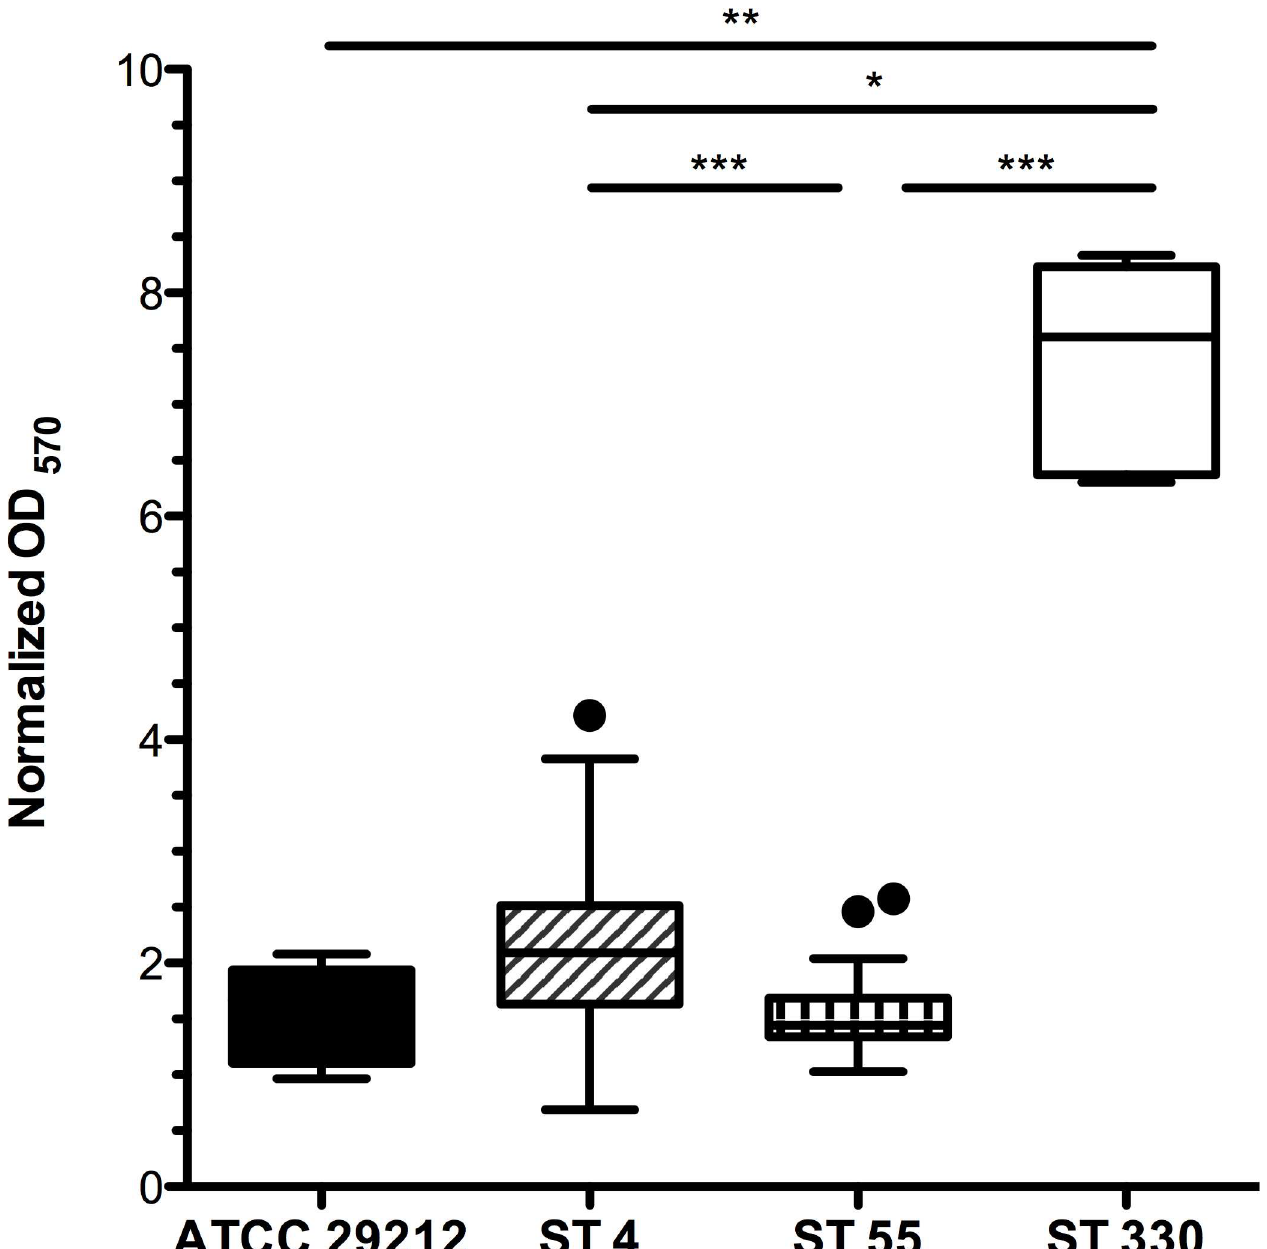
Fig 3. 24 hour Biofilm Production for 15 E . faecalis Isolates Assessedby Crystal Violet Staining. ST 4 and ST 330 isolates produce significantly more biofilm than ST 55 isolates (see also S4 Table). Mean normalizedOD 570 for pooleddata were 2.016 ± .0.016for ST 4 isolates, 1.500 ± 0.2942 for ST 55 isolates, 8.191 ± 0.1489 for the ST 330 isolate and 1.894 ± 0.1833 for the ATCC 29212 control strain.